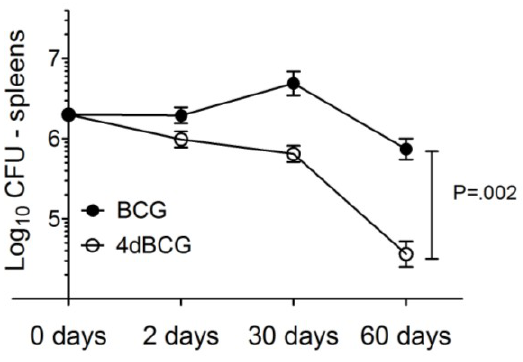
Figure 2. Spleen titers of BCG and 4dBCG in C57Bl/6 mice. Mean ± SEM spleen titers on day 2, day 30, and day 60 after IV inoculation of mice with 2 × 10 7 cfu of BCG or 4dBCG. Each value represents four to six mice. The P value represents the comparison of the BCG and 4dBCG groups at 60 days. The day 0 value is estimated as 10% of the original IV inoculum.